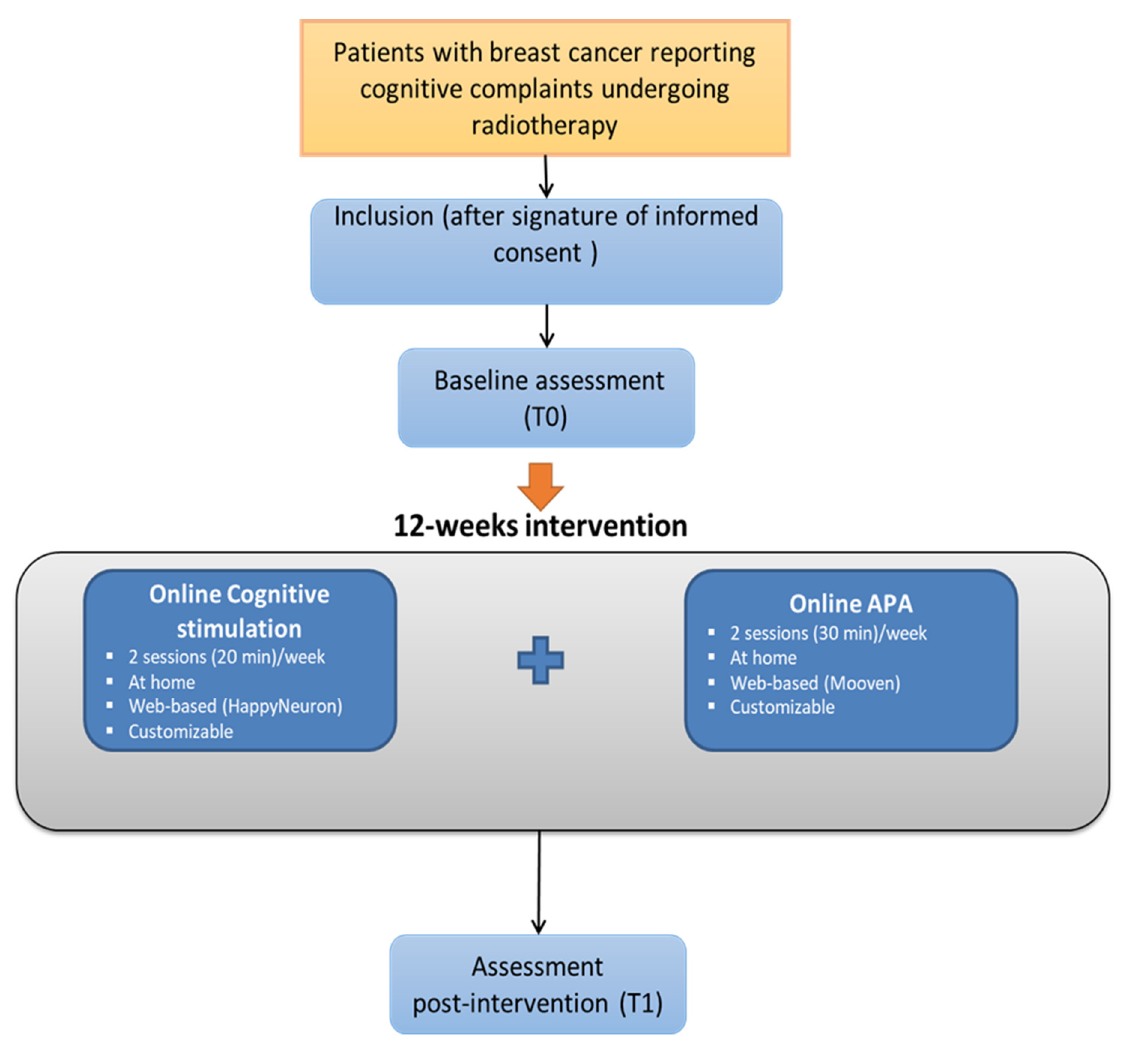
Figure 1. Study flowchart. APA: adapted physical activity.